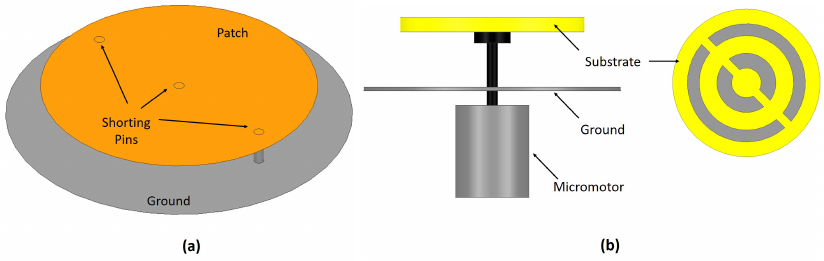
Figure 3. Illustrative reconfigurable resonant-type unit cells using rotating elements. ( a ) RA including a shorted circular disc. ( b ) Multi-resonator unit cell integrated with a micromotor beneath the reflector.